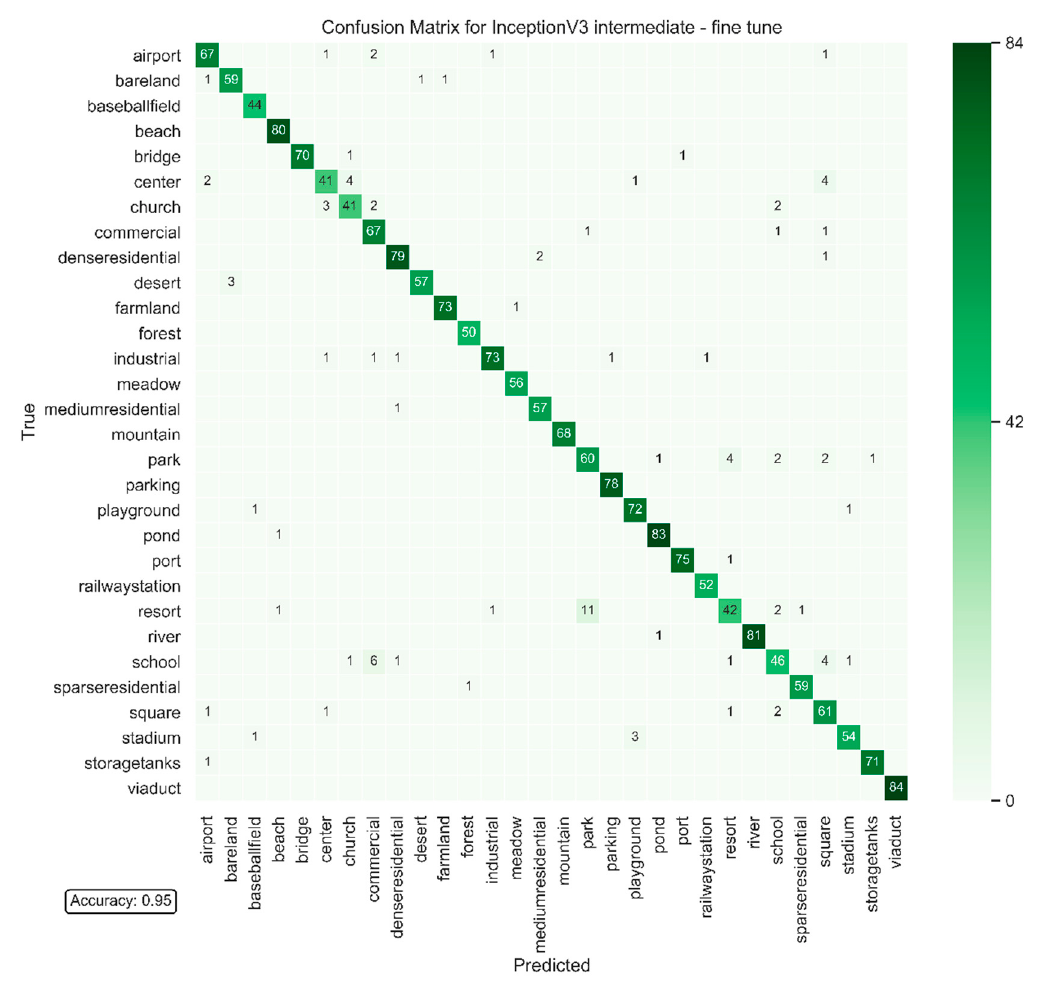
Figure 7. Confusion matrix for the test set of AID dataset for the Inception V3 intermediate in the fine-tune mode using SGD (1e-3) momentum 0.9.